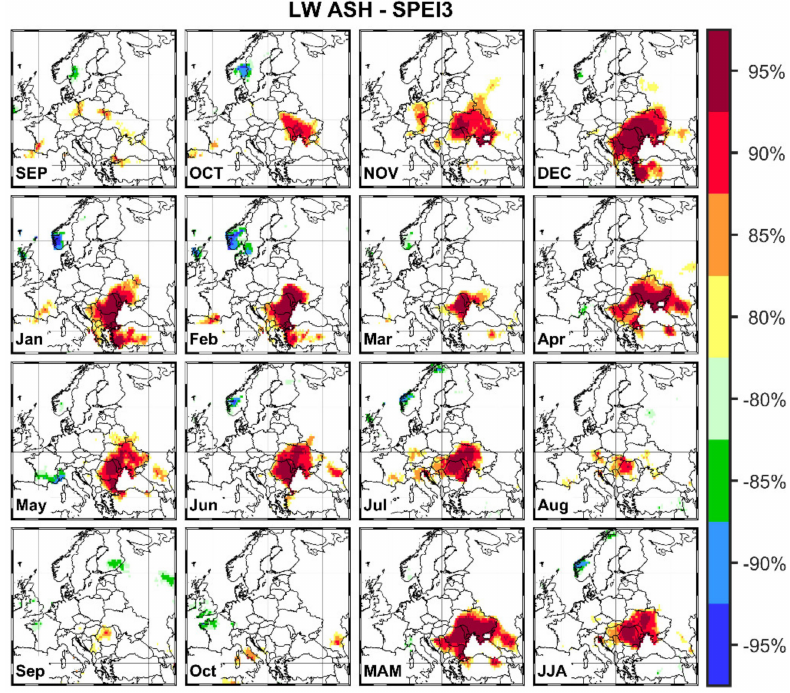
Figure 8. As in Figure 7, but for ash